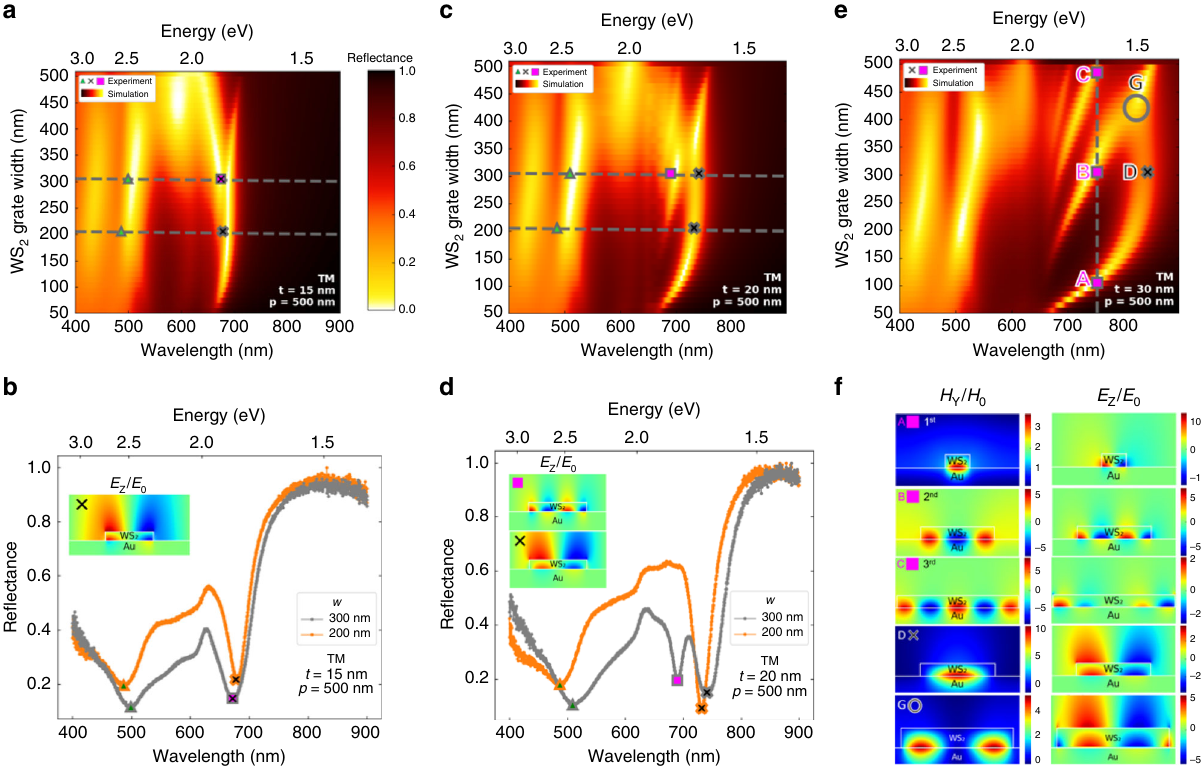
Fig. 4 Plasmonic modes above critical-thickness of WS 2 on Au. a Width dependence of simulated TM re fl ectance spectra. Period is fi xed at 500 nm, and thickness is fi xed at 15 nm (critical thickness). The plasmonic peak emerges from the lower exciton-polariton (LEP) of the unpatterned case indicating a hybrid nature of the mode. Re fl ectance color scale is the same for ( a , c , e ). b Experimental re fl ectance spectra of the WS 2 grating structure with t = 15 nm and p = 500 nm, and widths of 200 nm and 300 nm. Corresponding mode peaks are coded with matching symbols in ( a ). Inset is the E Z fi eld pro fi le of the fi rst order plasmon mode. The symbols on peaks measured in experimental spectra are marked on the simulated plots in ( a ). c Width dependence of simulated TM re fl ectance spectra. Period is fi xed at 500 nm, and thickness is fi xed at 20 nm (above critical thickness i.e. uncoupled regime). Since the thickness is suf fi cient to support cavity modes in the unpatterned case, plasmon modes (marked with square symbols) start emerging from the cavity mode. d Experimental re fl ectance spectra of the WS 2 grating structure with thickness and period fi xed at 20 nm and 500 nm respectively. Spectra for widths of 200 nm and 300 nm are compared. Inset are the E z fi eld pro fi les of the two plasmonic modes. The symbols on peaks measured in experimental spectra are marked on the simulated plots in ( c ). e Width dependence of simulated TM re fl ectance spectra. Period is fi xed at 500 nm, and thickness is fi xed at 30 nm, suf fi ciently above the critical thickness regime. For a photon wavelength of 750 nm, the resonant widths are equal to 100 nm (A), 300 nm (B), and 470 nm (C), forming 1st, 2nd, and 3rd order plasmon modes. The plasmon mode (D) stands at the lowest-energy resonance. The mode G marked at the crossing point of the 2nd order plasmon mode (B) and (D) indicates a hybrid mode with characters of both. f E Z , H Y fi eld pro fi les of the plasmonic modes labeled with corresponding points in ( e